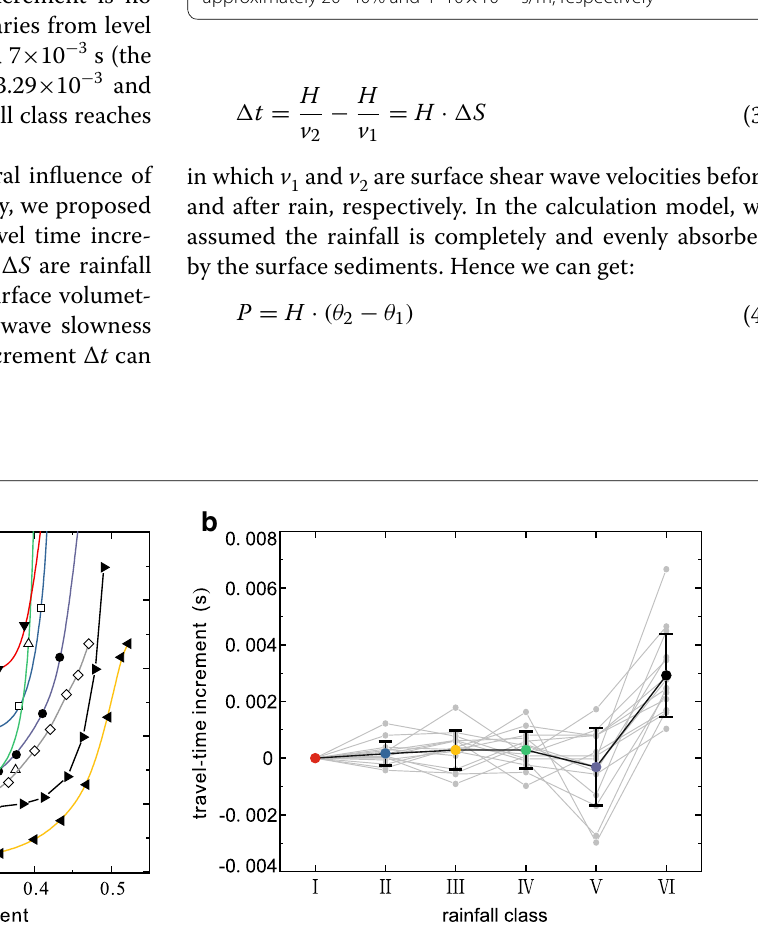
Fig. 5 (a) Relationships between shear wave slowness and volumetric water content for seven different types of soil (Dong and Lu, 2016). (b) Relationship between travel time increment and rainfall class for each seismic station (the gray lines). Black line represents cross‑plot between the mean travel time increment and rainfall class with error bars. The relationship between shear wave slowness and volumetric water content has a similar pattern with that of travel time increment and rainfall class